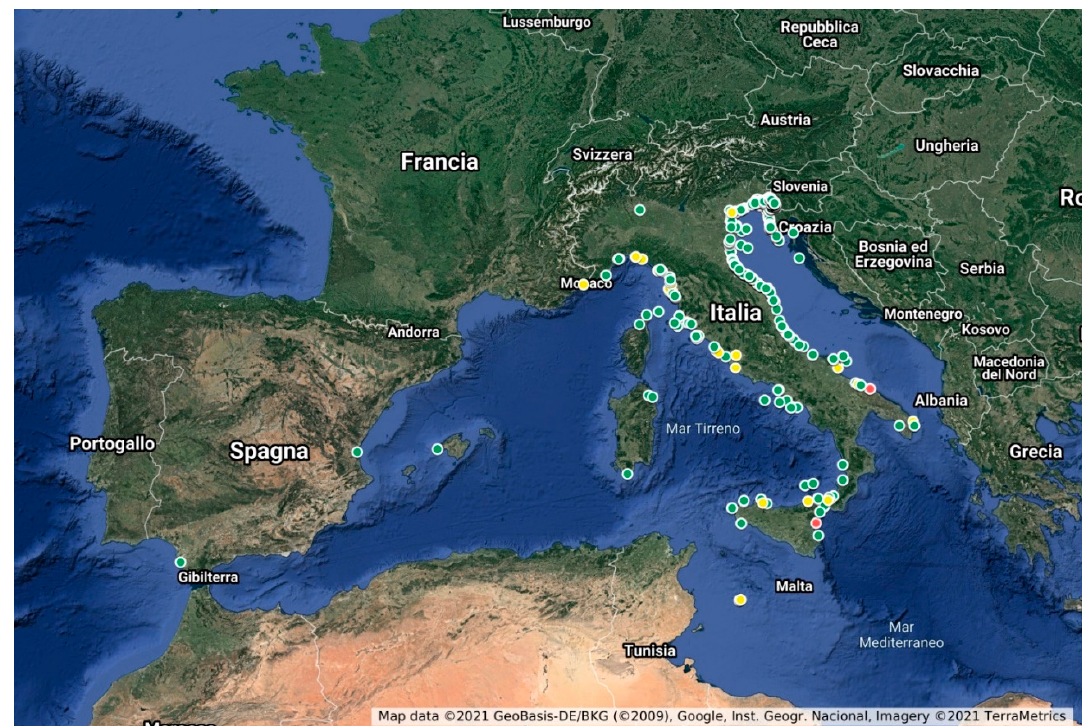
Figure 3. Map of the Mediterranean coast showing the locations of the sightings (green dot: correct sighting; yellow dot: incomplete sighting; red dot: wrong sighting).